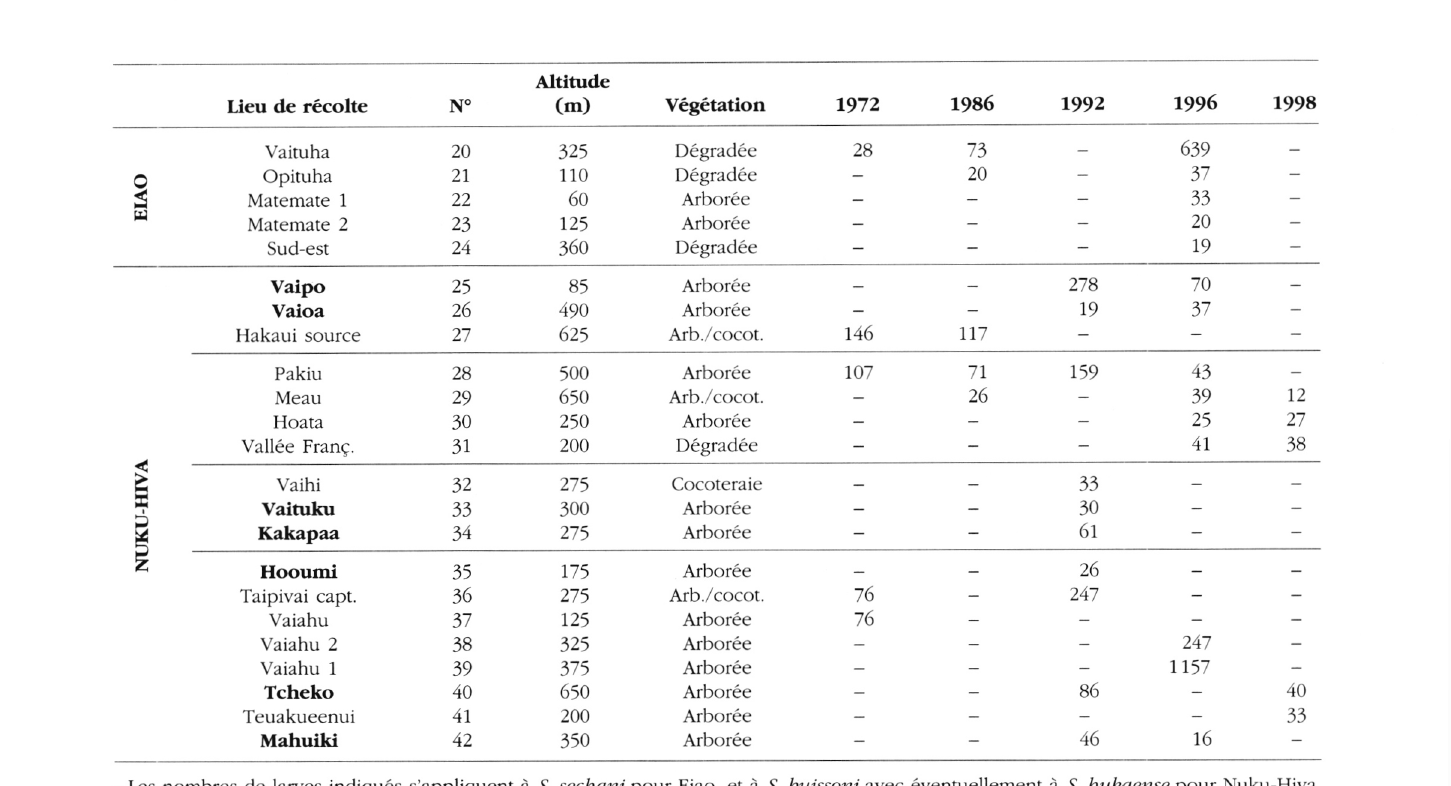
Tableau II. - Répertoire des stations de récolte situées à Eiao et à l’intérieur de la caldeira principale de Nuku-Hiva.